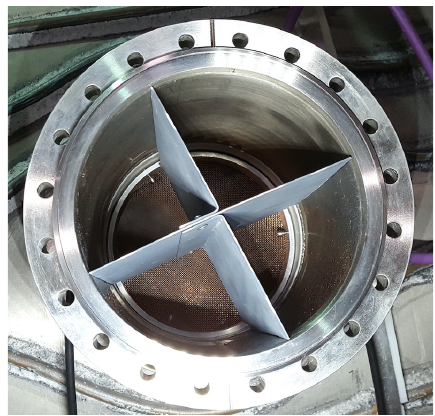
Figure 5. Protection of the vacuum gauges in the pumping port. The photo is take outside the MISTRAL with the vacuum pumps removed. At the far end of the port (vacuum side) the mesh is seen. The insert is a microwave absorber: an aluminum sheet coated with a microwave absorbing layer, refer to section 3.2.